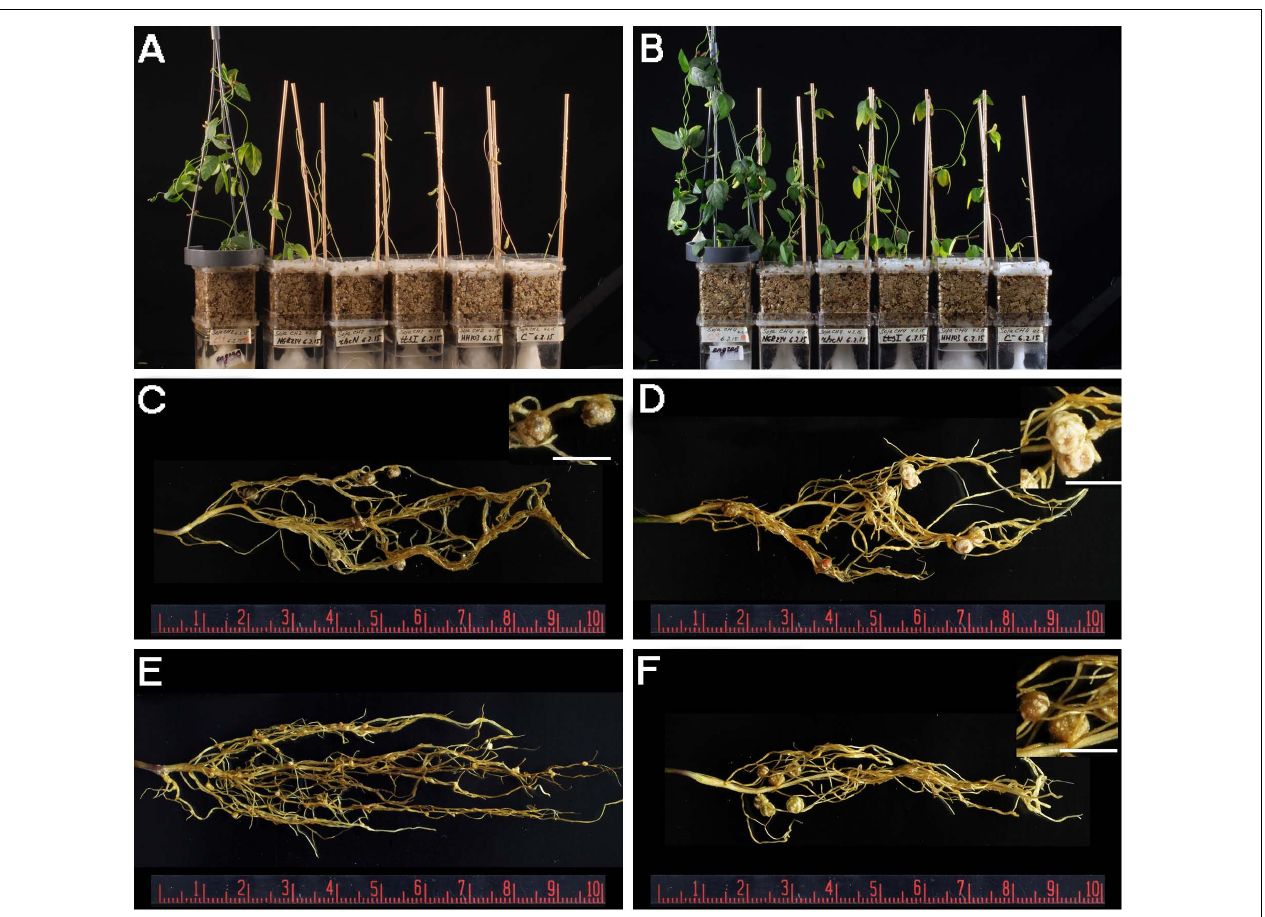
FIGURE 2 | (A,B) Plant responses of G. soja accessions CH2 (A) and CH4 (B) inoculated with different S. fredii strains. From left to right, Magenta jars were treated as follows: N-fertilizer, NGR234, NGR (cid:127) rhcN , NGR (cid:127) ttsI , HH103 Rif R , and uninoculated control. (C,D) Nitrogen-fixing nodules induced by NGR234 on CH2 (C) and CH4 (D) roots. (E) Ineffective nodules induced by HH103 Rif R on CH2 roots. (F) Nitrogen-fixing nodules induced by HH103 Rif R on CH4 roots. White bars (C,D,F) correspond to 5